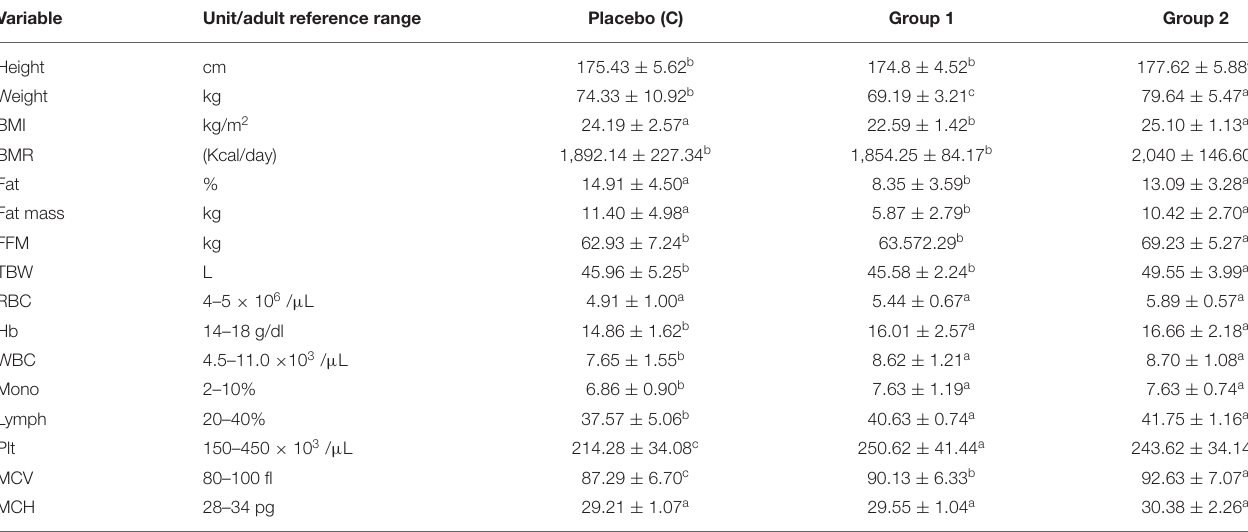
TABLE 3 | Effect of Pro-WPI products on anthropometric measurements and hematology biochemical parameters. Variable